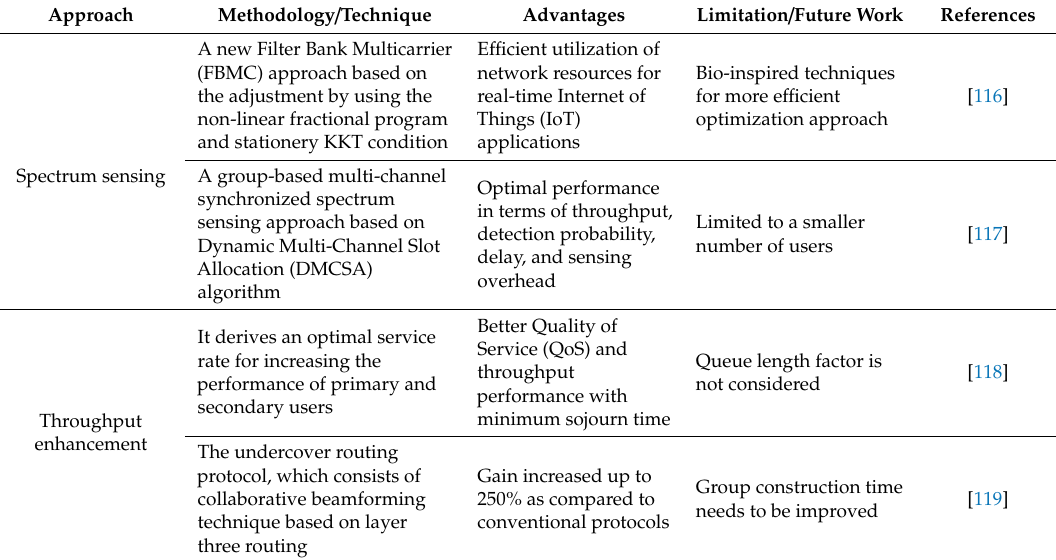
Table 2. Summary of the related work for